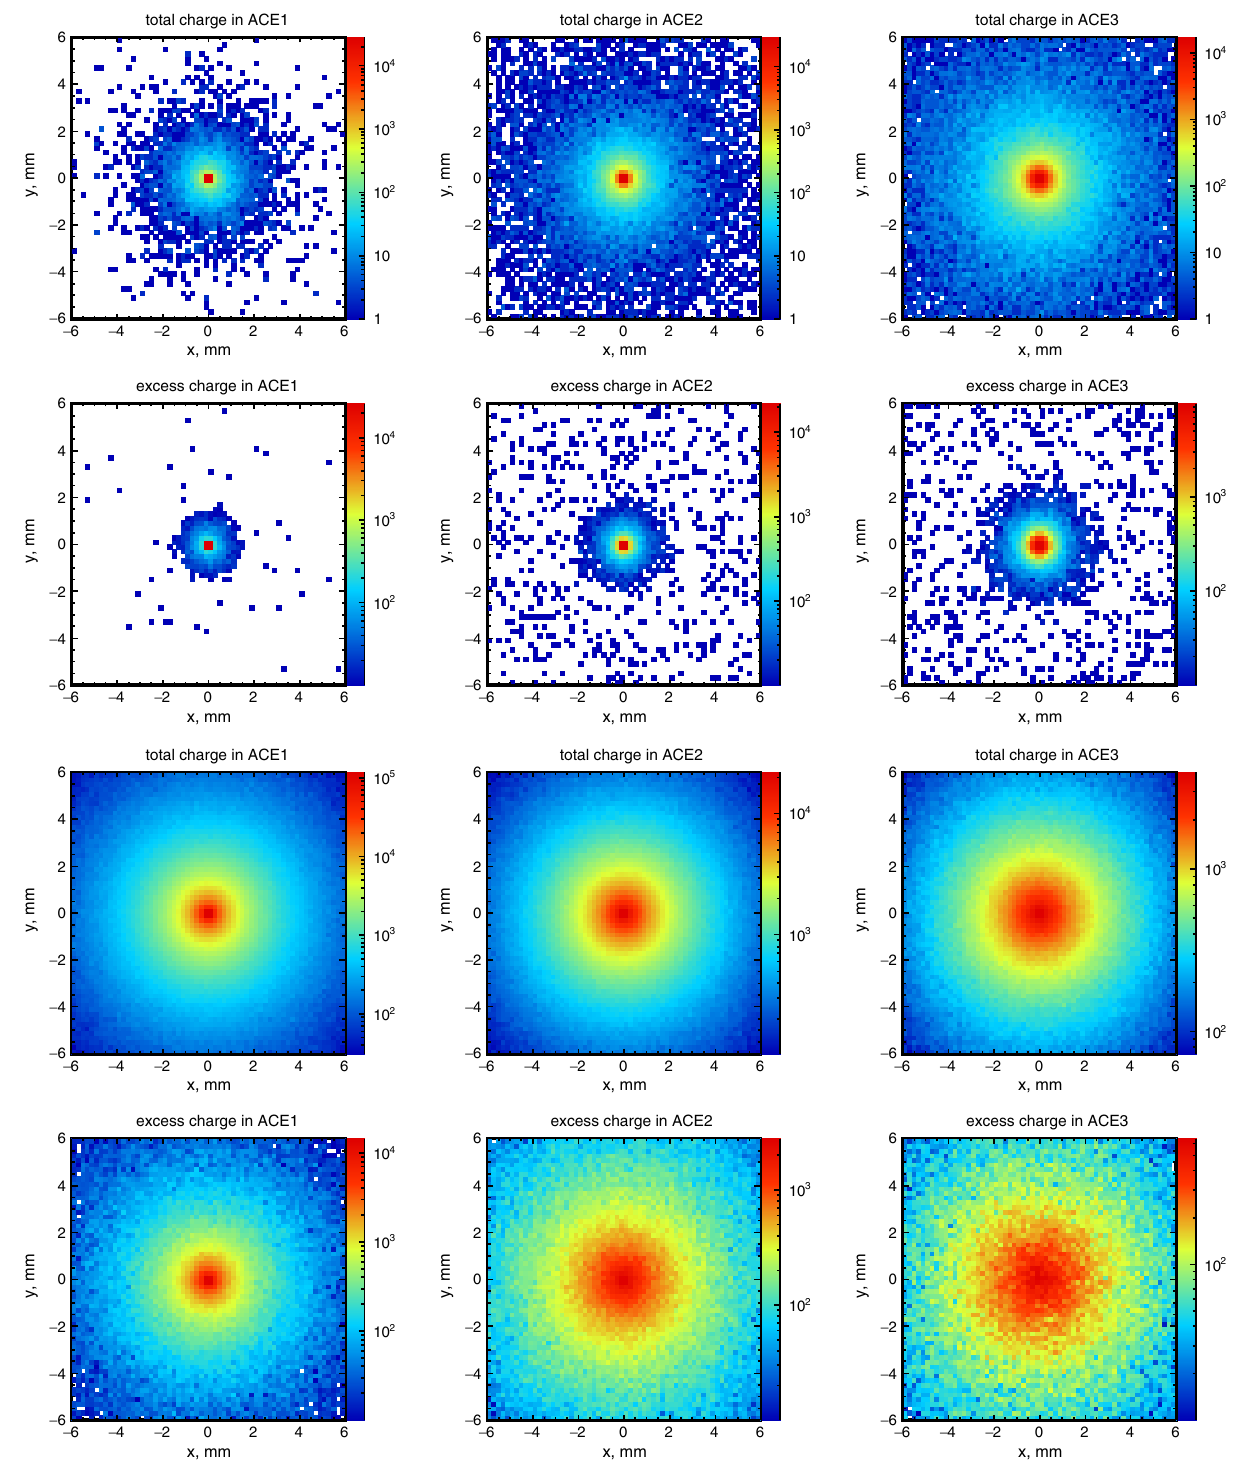
FIG. 3. GEANT 4 simulation of total and excess charge in the 3 ACE elements, averaged over 10 5 events. The top 2 rows give the results for 6.4 GeVelectrons, with no tungsten in the ACE system; only slight evolution of the bunch can be seen. The bottom two rows are for the full tungsten-loaded ACE with 12.16 GeV electrons; strong evolution of the shower is now